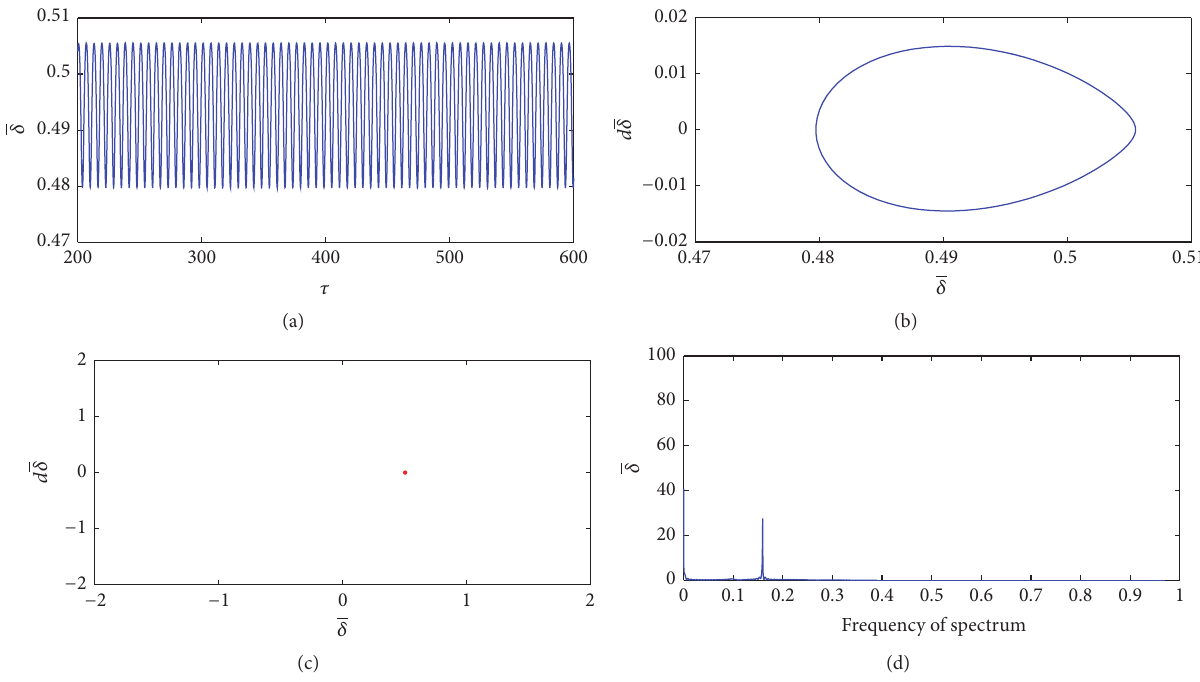
Figure 3: 𝜔 ℎ = 1: (a) time history; (b) phase plane; (c) Poincar ´ e map; (d) Fourier